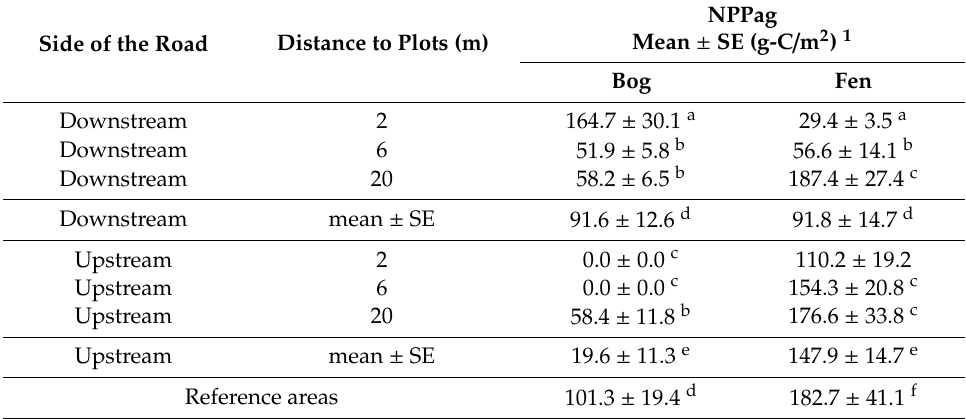
Table 4. Annual aboveground tree and shrub net primary productivity (NPPag) in the upstream, downstream sides (Side) of the road at the plots located at 2, 6 and 20 m perpendicular distance from the road edge and reference areas at bog and fen site during years post-road construction, Carmon Creek, Peace River, Alberta.